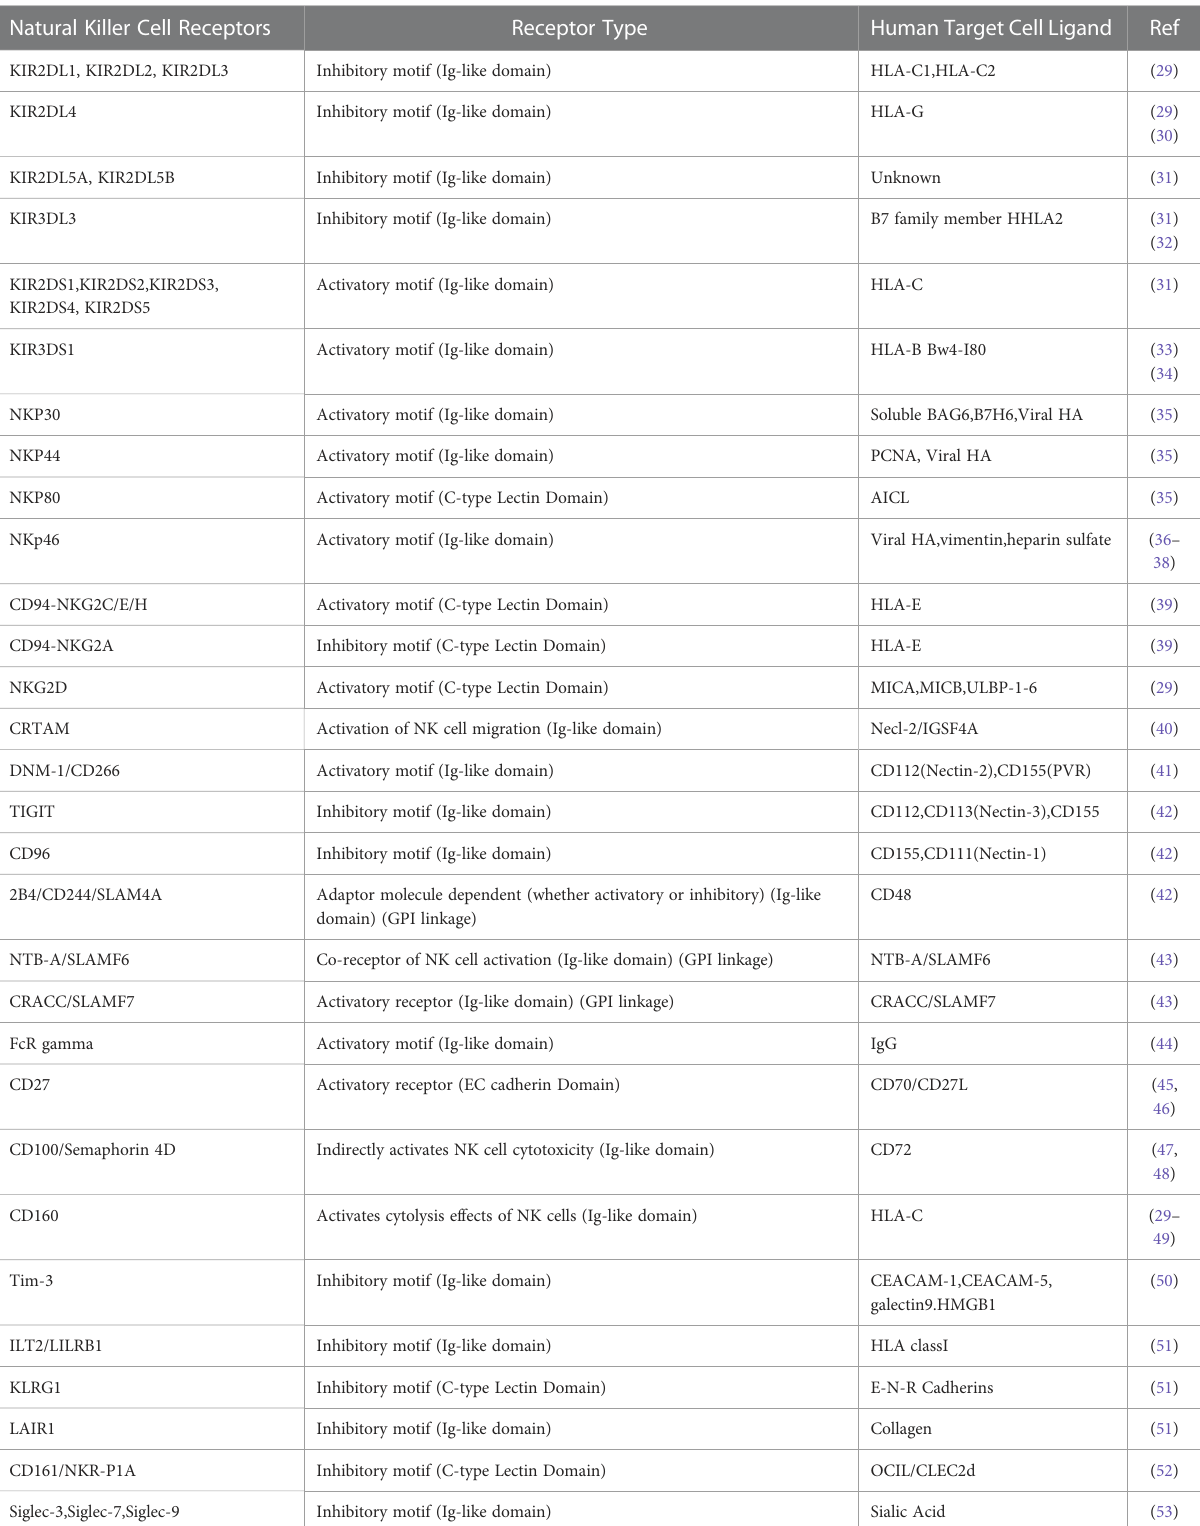
TABLE 1 Interaction of NK cells ’ receptor with tumor cells ’